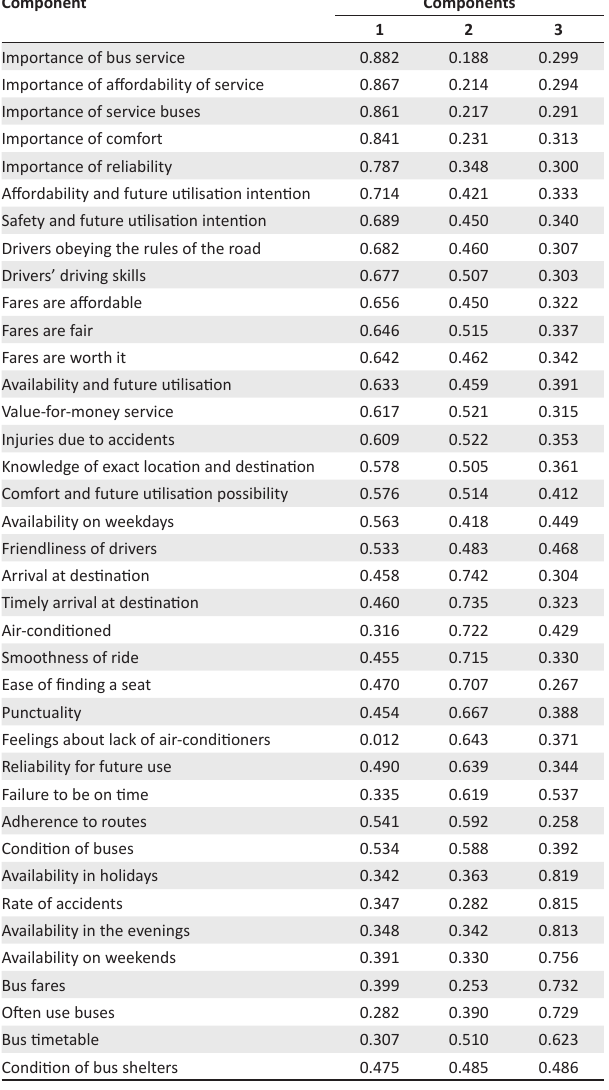
TABLE 2: Rotated component matrix.